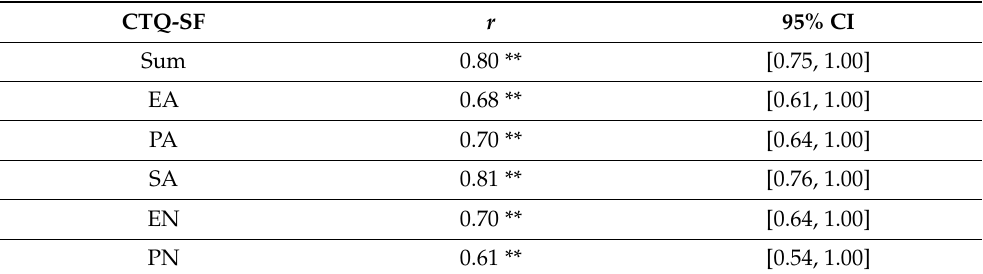
Table 2. Pearson Correlation Coefficients of CTQ Self-Assessment and External Assessment in the Total Sample.